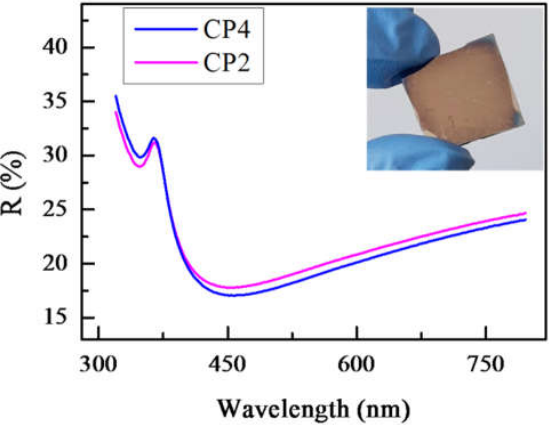
Figure 5. Reflectance spectra of CP2 and CP4 copolymer thin films and picture of CP2 film on silicon substrate as an inset. Table 3. Thickness, d, refractive index, n, extinction coefficient, k of CP2 and CP4 copolymer films, reflectance change (∆ R = │ R ac − R ar │ ) , thickness of the film exposed to acetone vapors, d ac , swelling